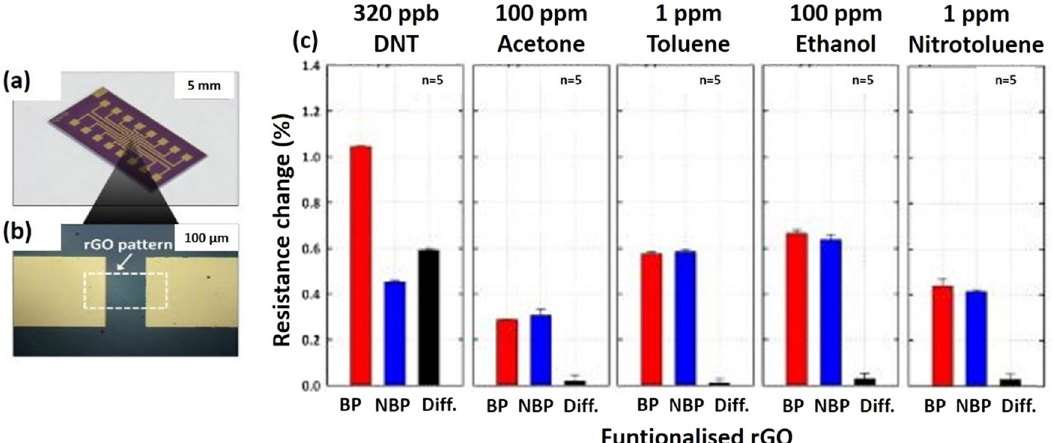
Figure 19: ( a ) Enlarged rGO chemical sensor with eight multiple arrays for DNT detection, ( b ) location of the rGO sensor patterns ( 200 μ m × 100 μ m ) between the Au electrodes, and ( c ) resistance change on fi ve di ff erent gases: the di ff erential values ( black bar ) of DNT - BP and DNT - NBP con fi rm the high selectivity. Adapted from ref. [ 127 ]